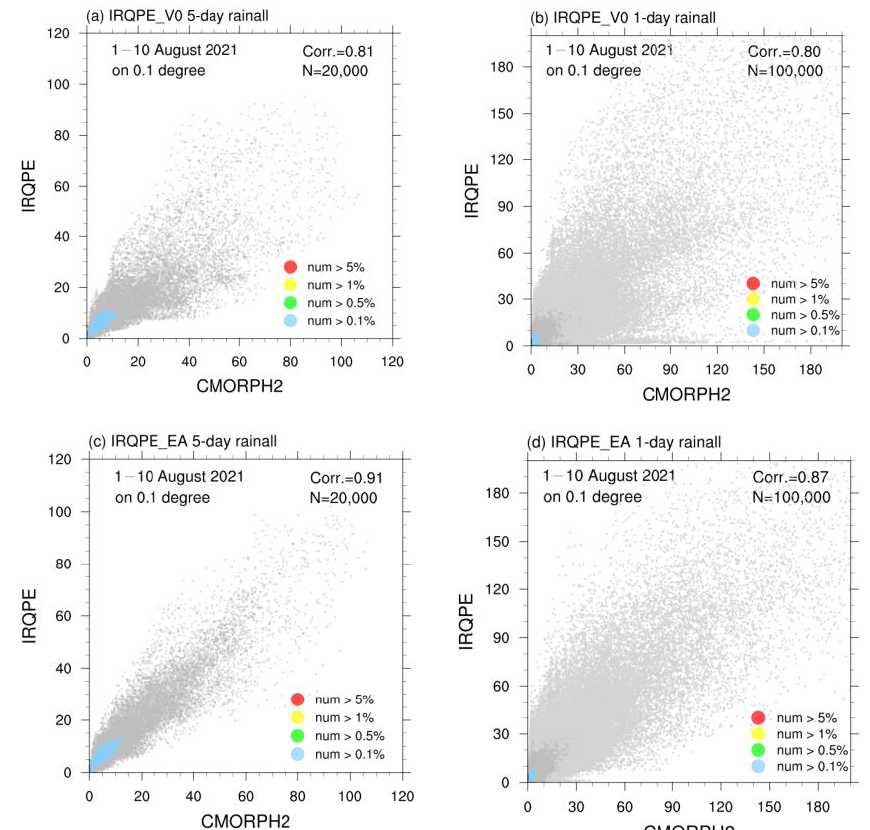
Figure 9. The point-to-point scatter plot for IRQPE and CMORPH2 over 20 ◦ N–30 ◦ N, 115 ◦ E–125 ◦ E on a spatial resolution of 0.1 ◦ lat/lon. ( a , b ) IRQPE_V0. ( c , d ) IRQPE_EA. Notice that ( a , c ) are on a 5-day basis data comparison. ( b , d ) are on a 1-day basis data comparison.